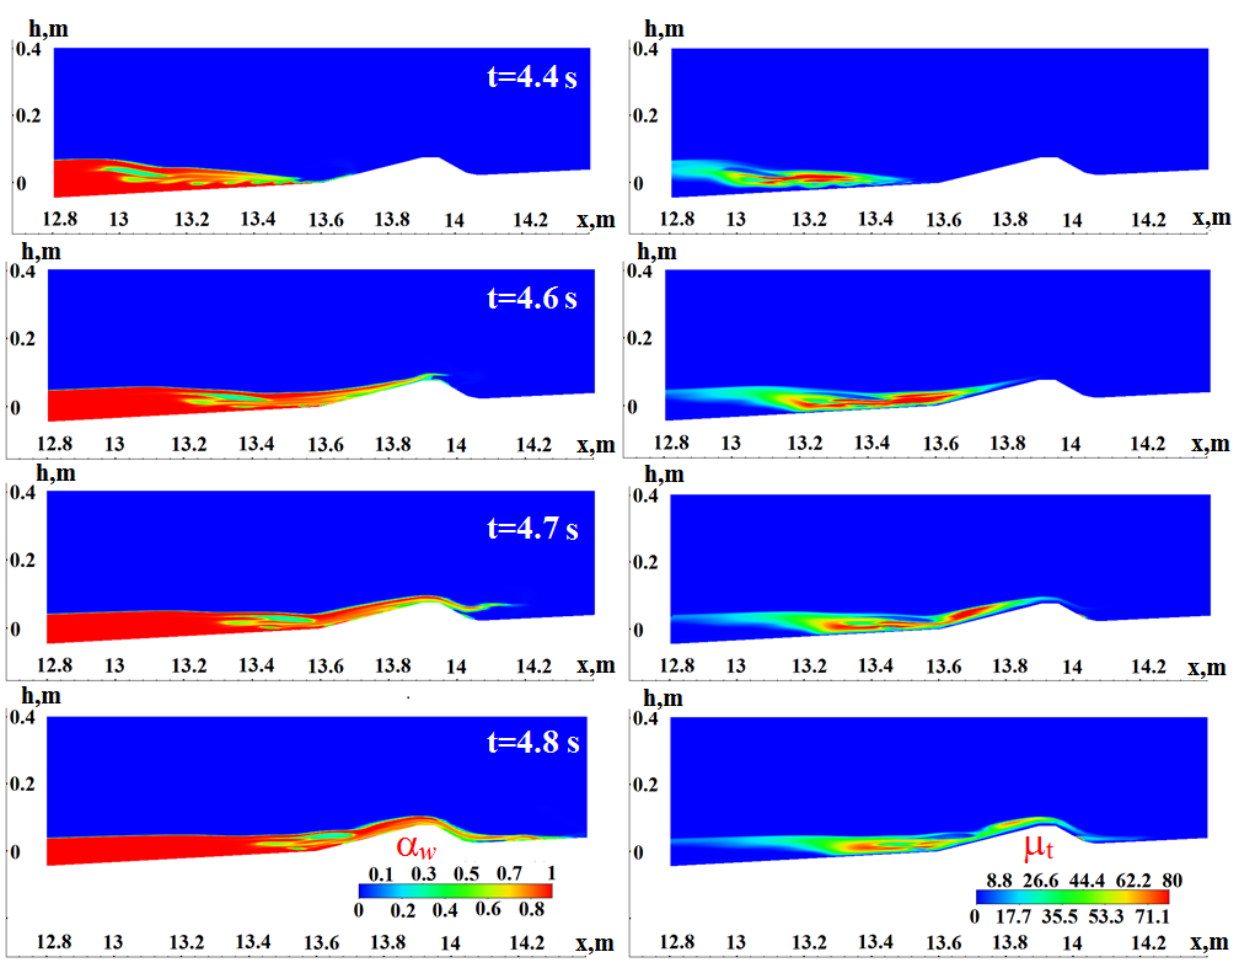
9 of 14 Figure 8. Comparison of the wave profiles for setup 3 ( —without TM, —with TM). The plots indicate that the wave runs up onto the barrier and then the fluid flows